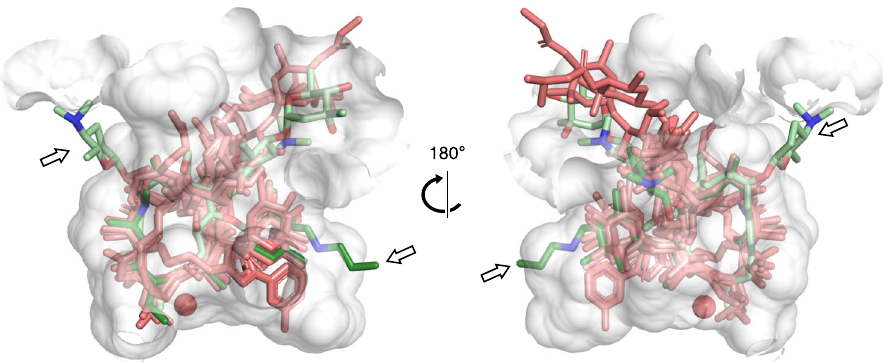
Fig. 3 Macrolide substrates and non-substrates in the active site of EreC. Various macrolides modeled into the active site of EreC based on the conformation of erythromycin. The gray surface represents the active site of EreC Closed . Macrolides that are a substrate of EreC are colored in pink, spiramycin is colored in light green, and tulathromycin is colored in dark green. The catalytic water is represented as a red sphere. The arrows indicate the position of protein-macrolide steric clashes.